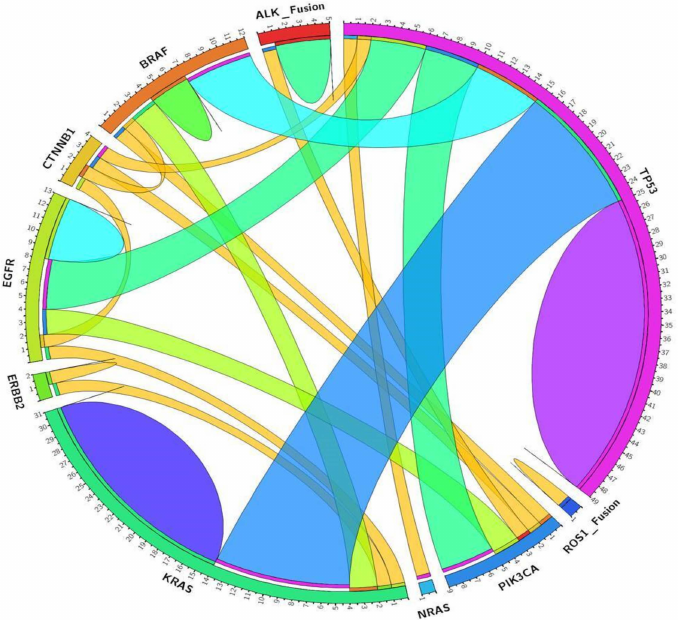
Figure 2. Circos diagram. Associations among the most prevalently mutated genes in NSCLC patients. Fifty mCRC patients harbored concurrent mutations. KRAS mutations were found to be concomitant with TP53 ( n = 11), PIK3CA ( n = 5), SMAD4 ( n = 3) and FBXW7 ( n = 1), CTNNB1 ( n = 1) and AKT ( n = 1). BRAF p.Val600Glu mutation was found in concurrency with TP53 ( n = 3), PTEN ( n = 1), PIK3CA ( n = 1) and SMAD4 ( n = 1). NRAS and PIK3CA were concomitant in one